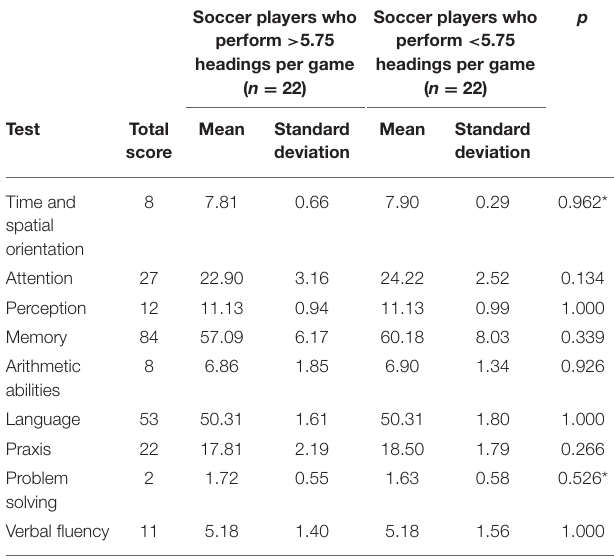
TABLE 5 | Comparison between sub-groups of soccer players on Neupsilin battery. Soccer players who Soccer players who perform > 5.75 perform <